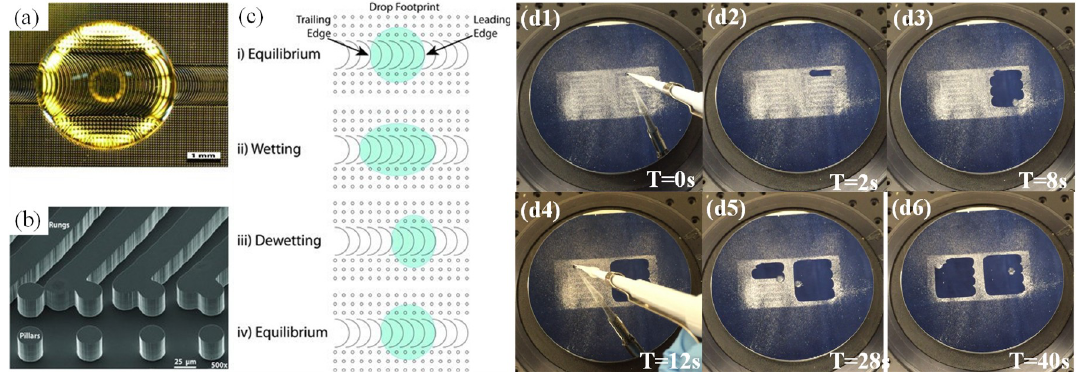
Figure 14. ( a ) A water droplet resting on the anisotropic ratchet conveyors (ARC) surface with etched pillars. ( b ) SEM image of the ARC surface. ( c ) Schematic of droplet interaction with droplet under vibration. The leading edge conforms to the semi-circular rung, which acts as a wetting barrier, while the trailing edge has only intermittent contacts with the rung pattern. Reproduced with permission from [124], published by ACS Publications, 2012. Reproduced with permission from [137], published by Wiley Online Library, 2012. ( d ) Surface cleaning performance for powdered sweetener (dextrose, maltodextrin, and sucralose) contamination on a chemically flat ARC surface consisting of two loop tracks. Reproduced with permission from [138], published by IEEE, 2017.